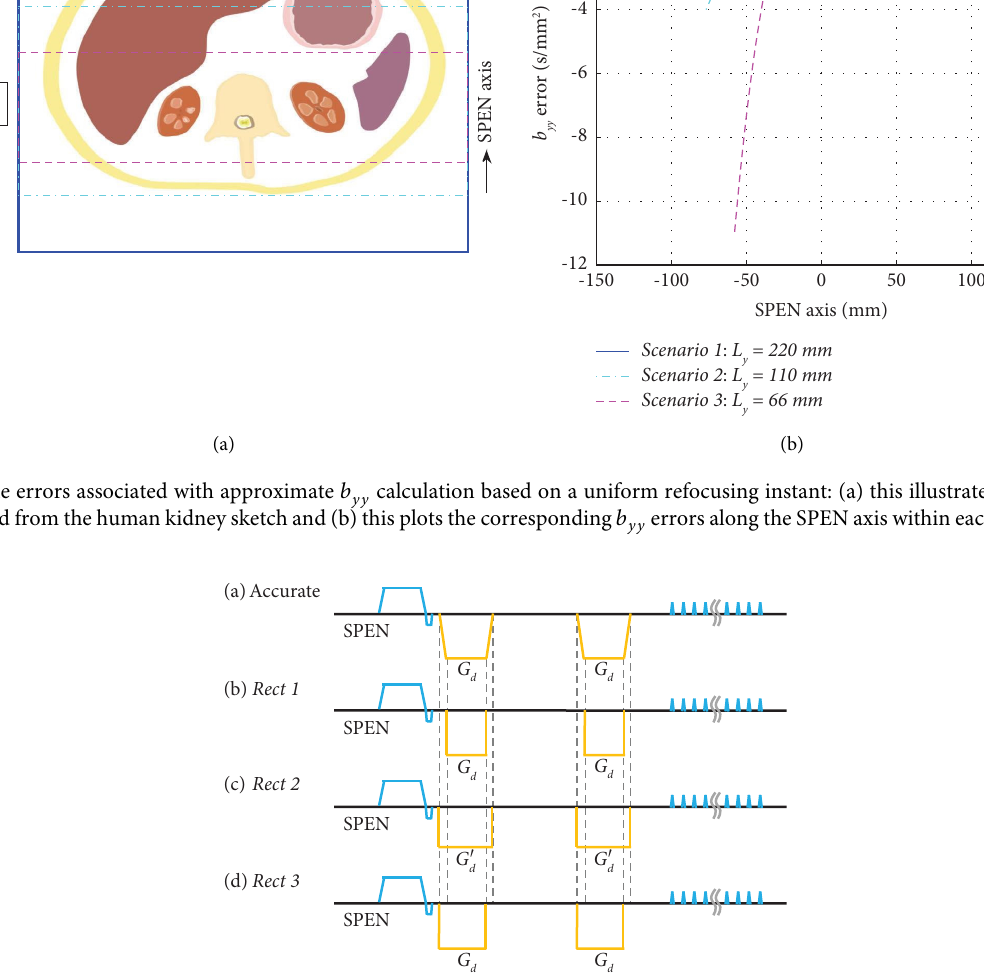
Figure 9: Illustration of gradient pulses along the SPEN axis (a) and three rectangularization schemes for difusion-sensitizing gradients: (b) Rect 1 , (c) Rect 2 , and (d) Rect 3 . Te gradient amplitude G d ′ indicates that Rect 2 has a diferent amplitude from difusion-sensitizing gradients ( G d ). Table 6: Te b 2 ) and their relative error associated with the rectangularization of difusion-sensitizing gradients. yy values (unit: s/mm